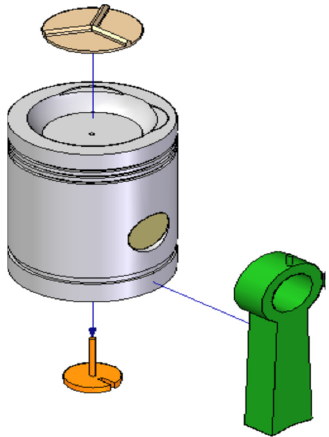
Figure 3. Exploded view of modified engine piston [23].